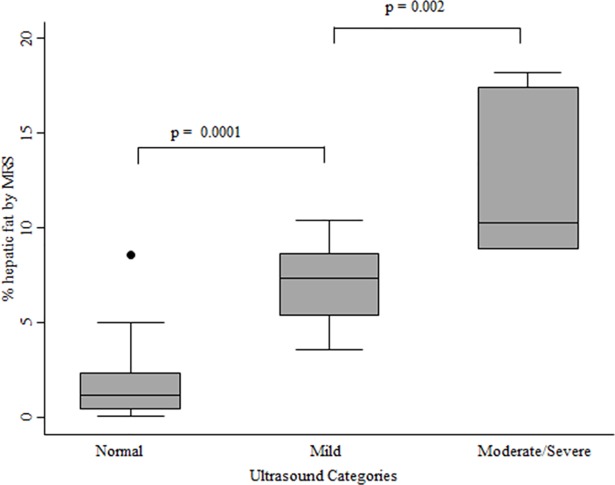
Box and whisker plot of MRS hepatic steatosis levels by ultrasound category.The lower boundary of the box indicates the 25th percentile, the line within the box is the median value and the upper boundary of the box indicates the 75th percentile. The whiskers indicate the minimum and maximum data values. If outliers are present the wiskers extend to the nearest data observation which lies within 1.5 times the interquartile range from the box. The moderate and severe scores were combined due to the small number of individuals in these categories.